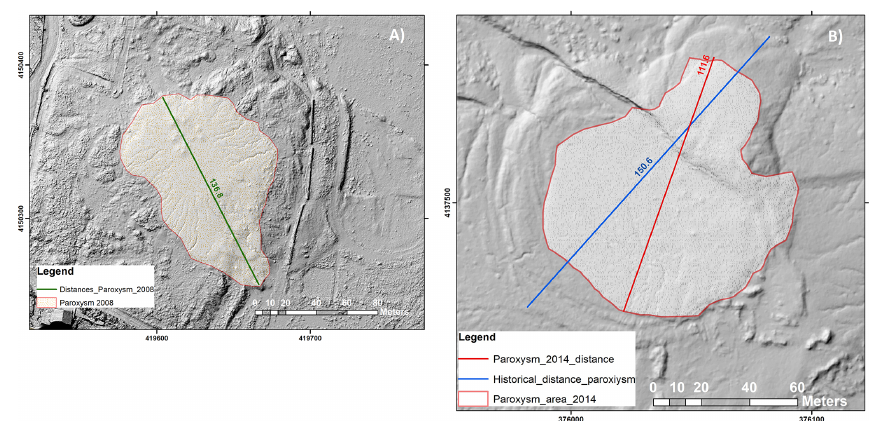
Figure 4. Historical distances reached by the erupted paroxysm material: (A) Santa Barbara and (B) Aragona (source: 2017 DSMs in ArcGIS 10.5).